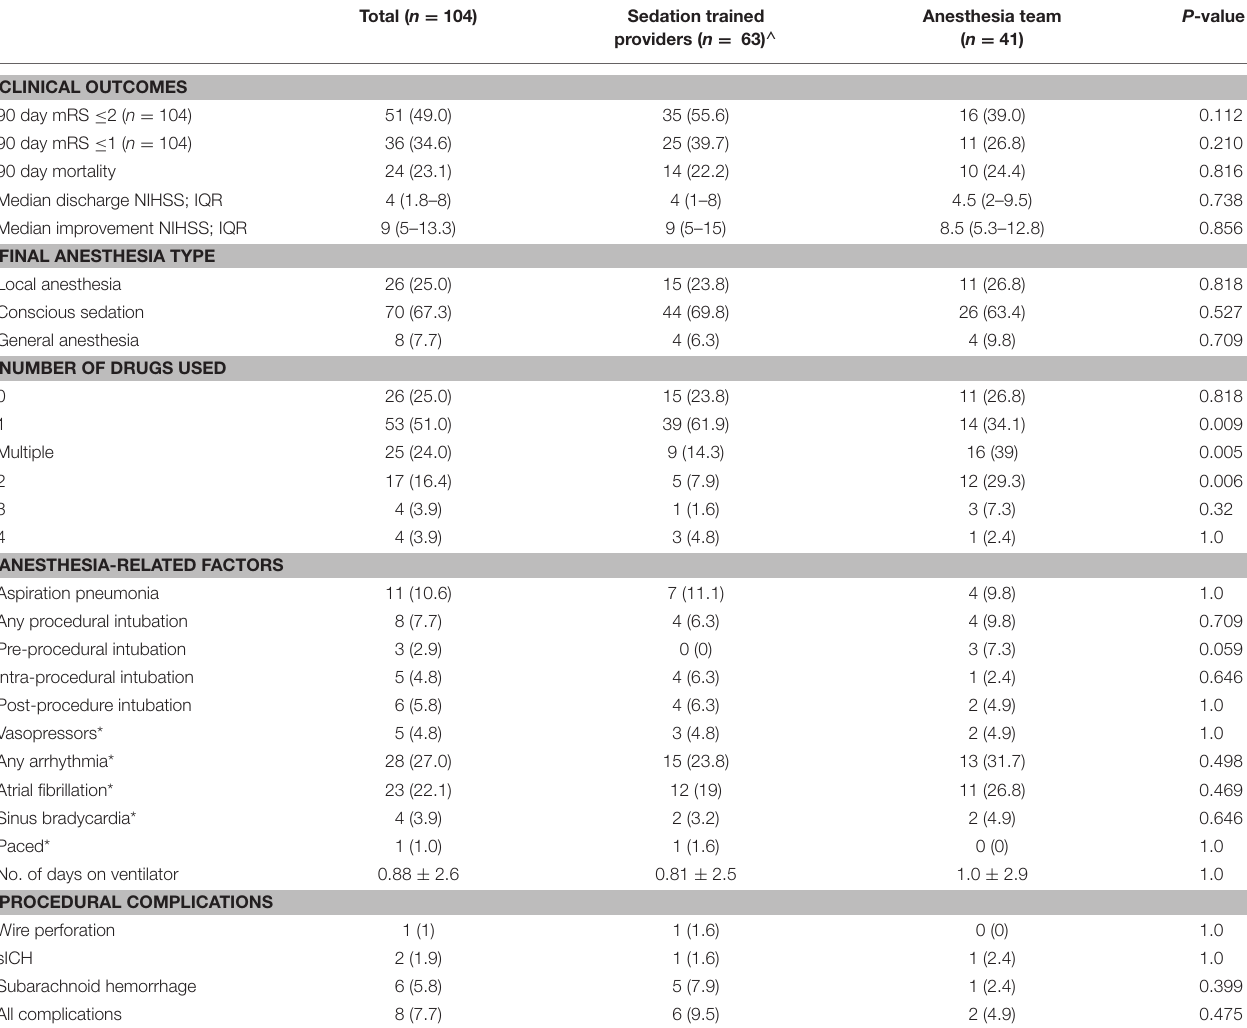
TABLE 2 | Patient outcomes, details pertaining to anesthesia, and procedural complications.